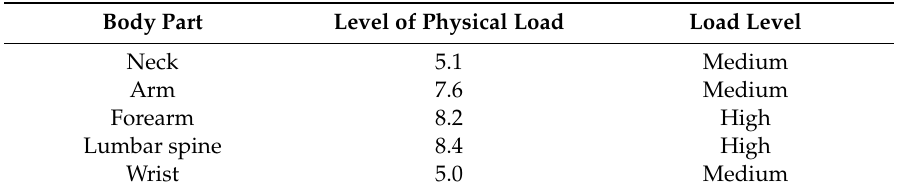
Table 2. Subjective assessment of the average load level expressed in range of 1–10 resulting from silage feeding (manual loading, transport and unloading).